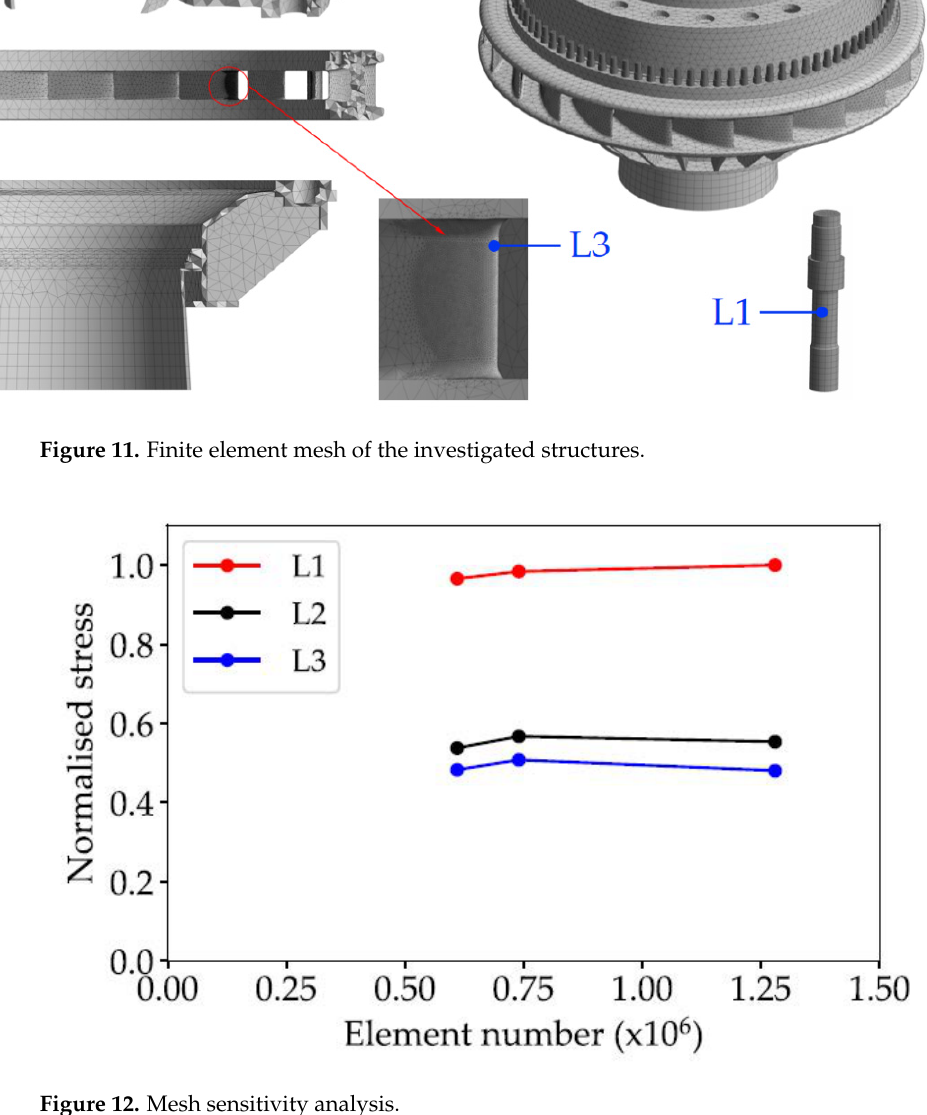
Figure 12. Mesh sensitivity